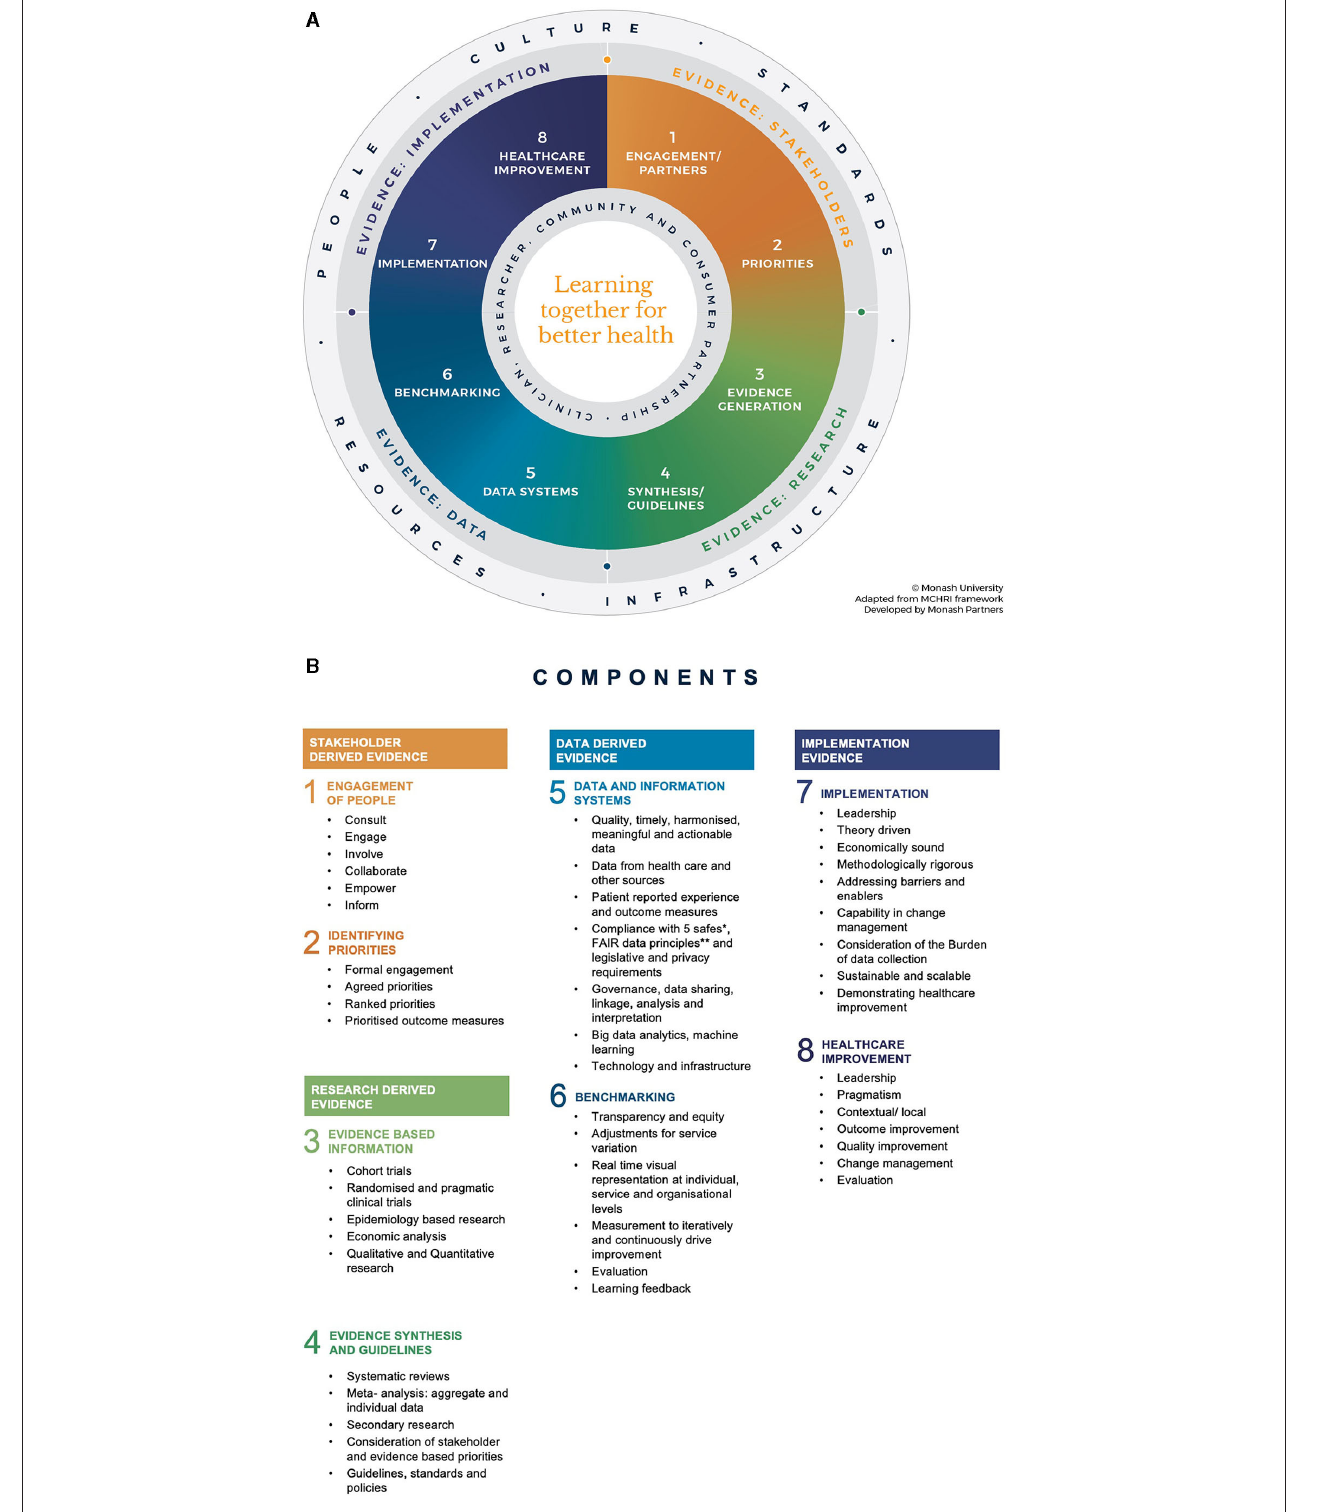
FIGURE 1 | (A) Monash Partners Learning Health System framework. The framework shows four key sources of evidence, with each represented diagrammatically in a quadrant of the Learning Health System cycle. (B) Bullet points list the topics and functions incorporated under each sub-section in the overarching LHS framework. The numbers correspond to the numbered sections in the LHS framework shown in (A) .